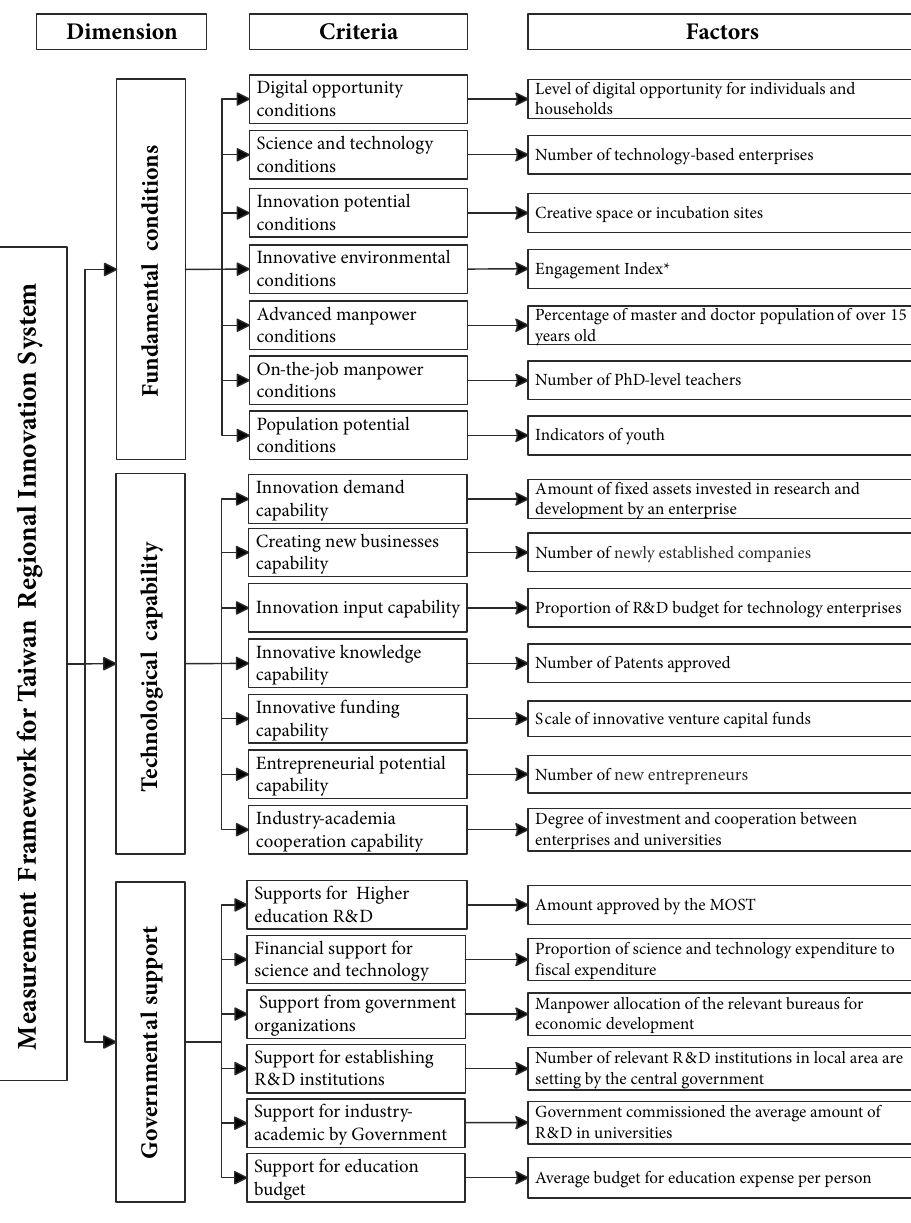
Figure 2. Evaluation framework for Taiwan regional innovation